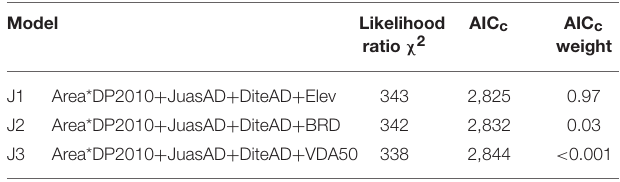
TABLE 3 | The three top regression models for incidence of crown death in Ashe